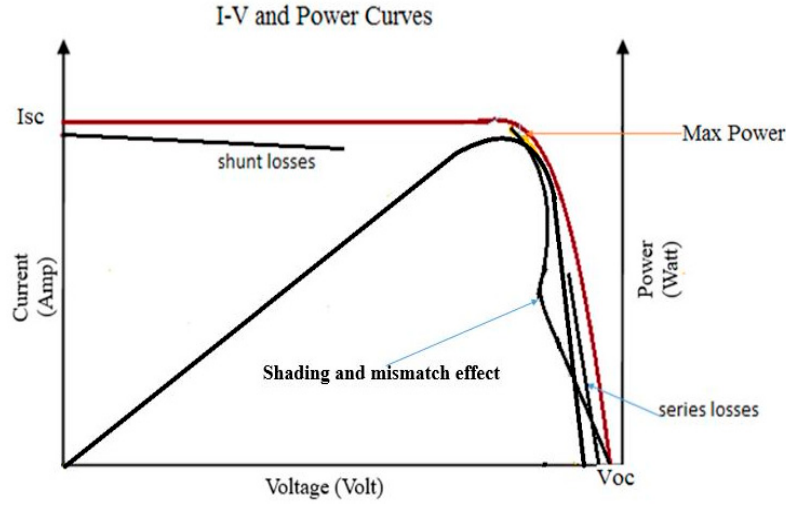
Figure 2. Possible losses within PV modules.